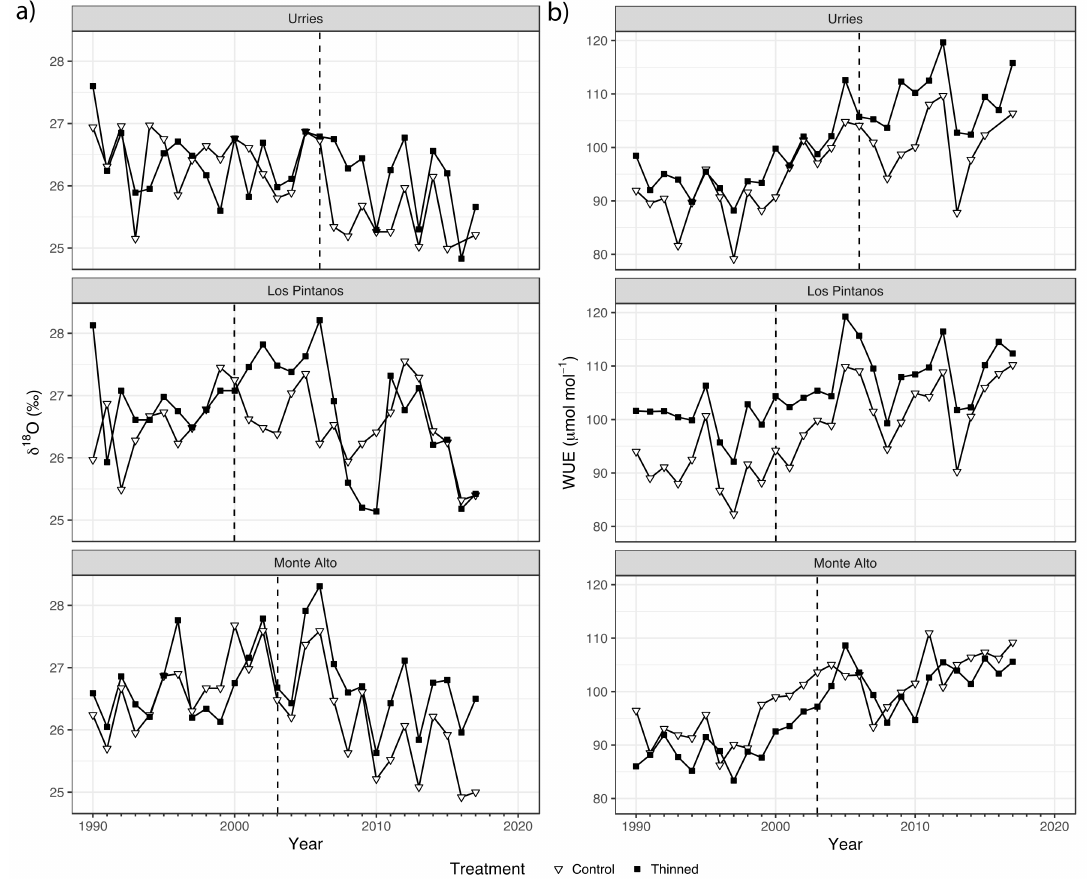
Figure 4. Time series of δ 18 O ( a ) and the intrinsic water-use efficiency (WUEi, ( b )) in Urri é s, Los Pintanos, and Monte Alto study sites: control (white triangles) and thinning (black squares). The dashed vertical lines represent thinning treatments (2006, 2000, and 2003 in Urri é s, Los Pintanos, and Monte